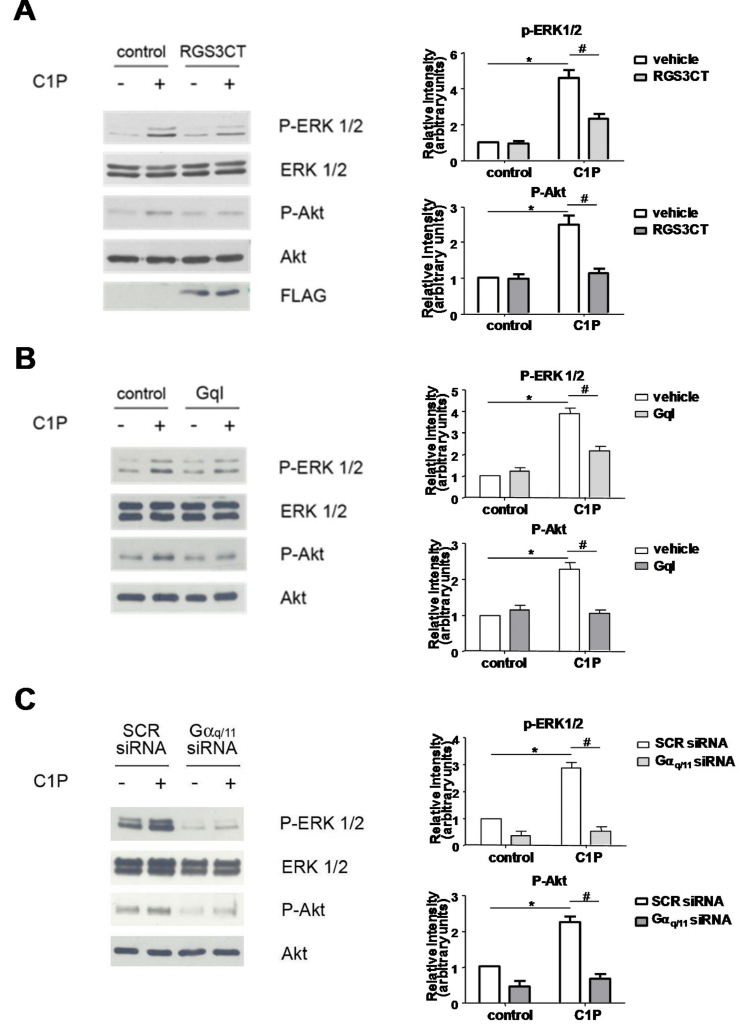
Figure 1. C1P signaling relies on G α q/11 engagement. C2C12 cells were transfected with pcDNA3.1-RGS3CT tagged with: FLAG-tag M2 epitope or empty vector ( A ); transiently transfected with pRK5-GqI or empty vector ( B ); or with scrambled (SCR)- or G α q/11-siRNA ( C ). Cells were overnight serum-starved prior to be stimulated with 15 µ M C1P for 5 min. Left panels: ERK1/2 and Akt activation was measured in total cell lysates by Western blotting analysis using anti-phospho-ERK1/2 and anti-phospho-Akt antibodies. In ( A ), the efficiency of transfection was checked by WB analysis of the FLAG-tag. A blot representative of three independent experiments is shown. Right panels: Band intensity was quantified by densitometric analysis and normalized to the expression of total ERK1/2 and total Akt, respectively. C1P activates ERK1/2 and Akt in a statistically significant manner by Student’s t test (* p < 0.05); the effect of G α q/11 down-regulation/inhibition was statistically significant by two-way ANOVA followed by Bonferroni’s post hoc test ( # p <